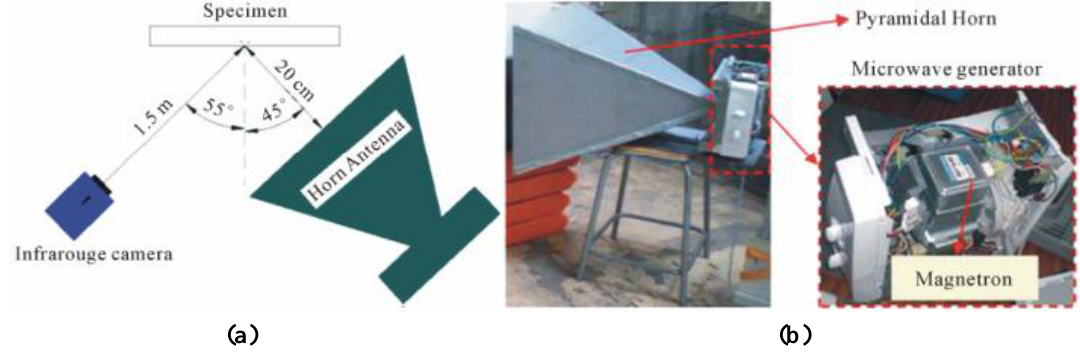
Figure 14. MWT setup ( a ) and Horn ( b ) in University Institute of Technology of Bethune [56]. Reprinted/reproduced with permission from Scientific Research Publishing Inc.